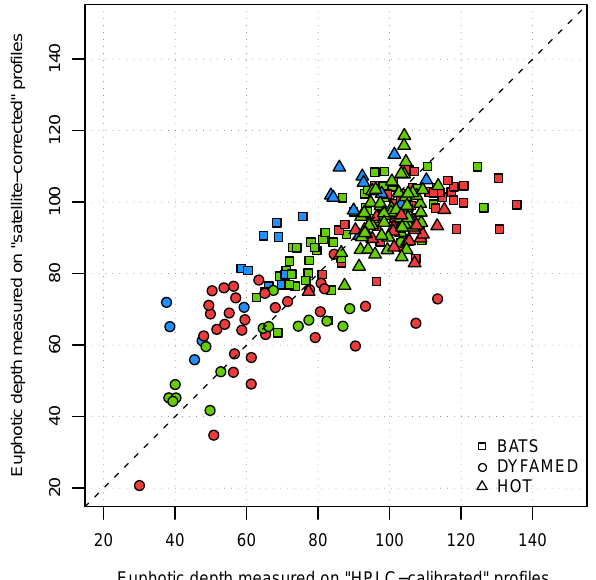
Fig. 4. Scatter plot of the euphotic depth computed on “satellite- corrected” profiles as a function of the euphotic depth computed on “HPLC-calibrated” profiles using the algorithm described by Morel and Berthon (1989). Both euphotic depths are expressed in meters (m). Similarly to Fig. 1, colour code refers to the error of satellite in the estimation of near-surface Chl a C .